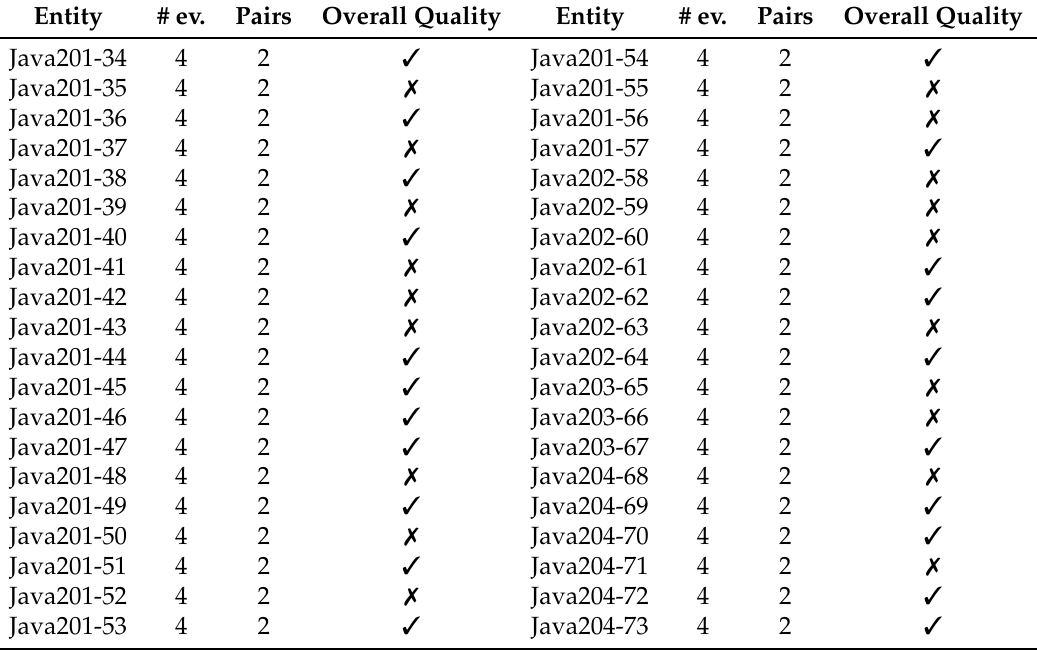
Table 16. Results of expert judgment of assessed Java classes evaluated based on an individual software metric.